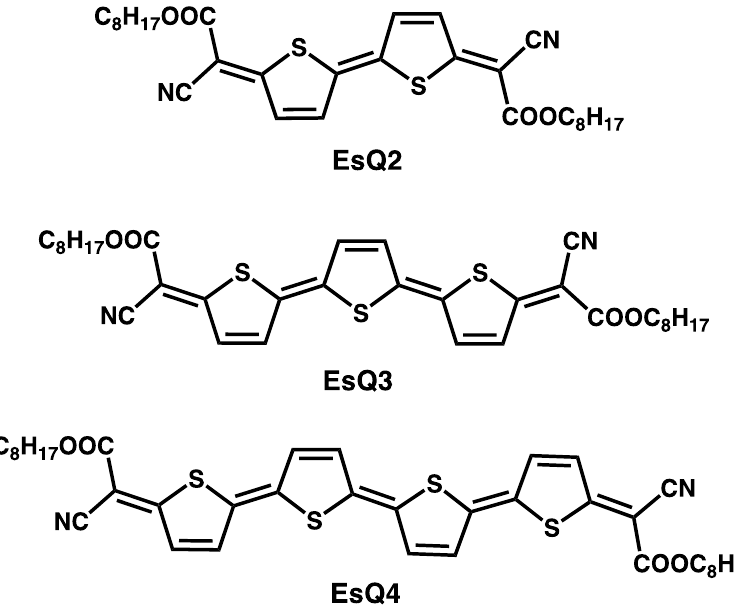
Figure 1. Chemical structure of cyano-ester quinoidal